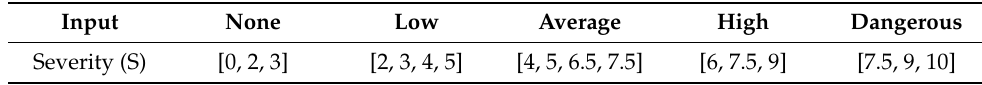
Table 1. Linguistic variables and membership functions for severity (S).